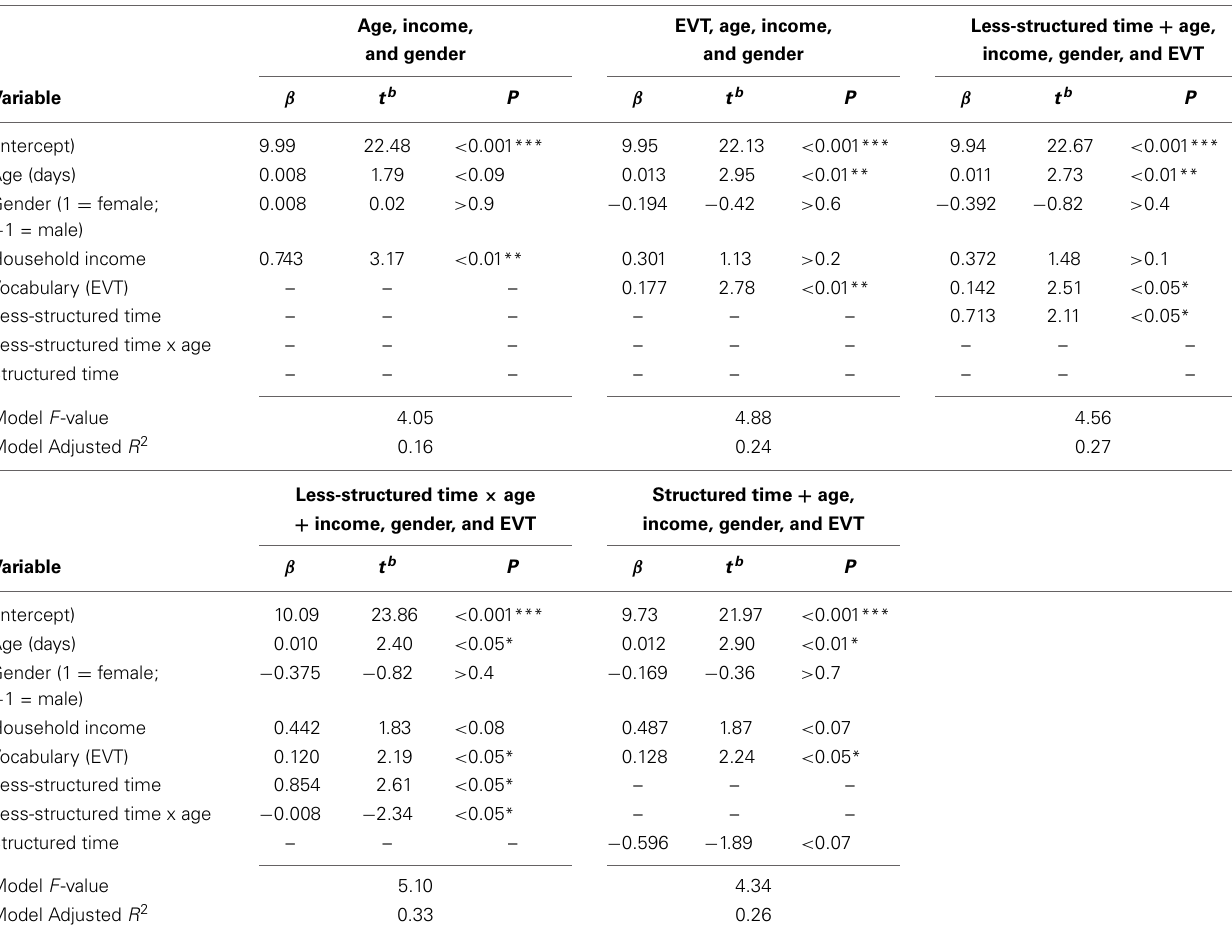
Table 3 | Effects of age, gender, income, vocabulary and time use on child verbal fluency performance. Age,